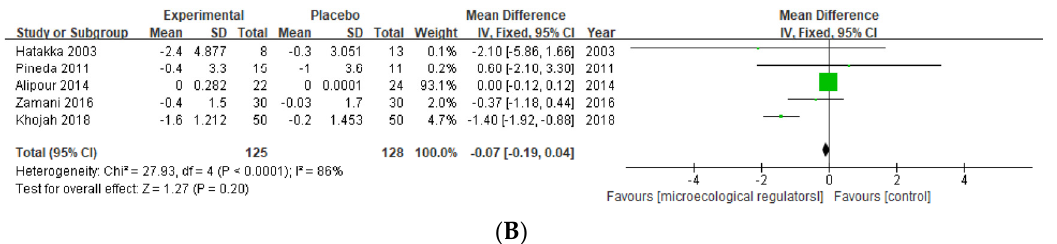
Figure 5. ( A ) Forest plot of TJC-28 variations in rheumatoid arthritis; ( B ) forest plot of SJC-28 variations in rheumatoid arthritis [36,39,40,42,44].